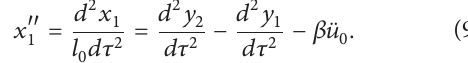
critical components is perfect under the action of half-sine pulse. When 𝜏 0 = 0.5 , 𝜑 0 = 60 ∘ , 𝜆 1 = 10 , and 𝜆 2 = 0.01 , with dimensionless peak pulse acceleration ( 𝛽 ̈𝑢 0𝑚 = 0.01 , 0.05 ,